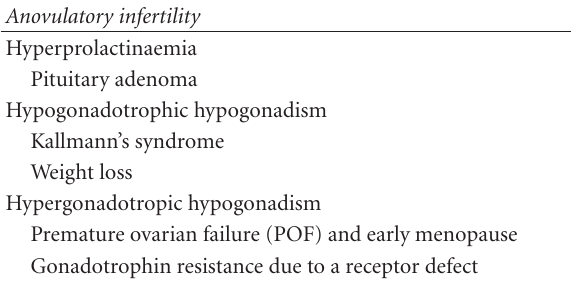
Table 1: Etiology of female infertility (based on the diagnostic and treatment guidelines provided by [1,